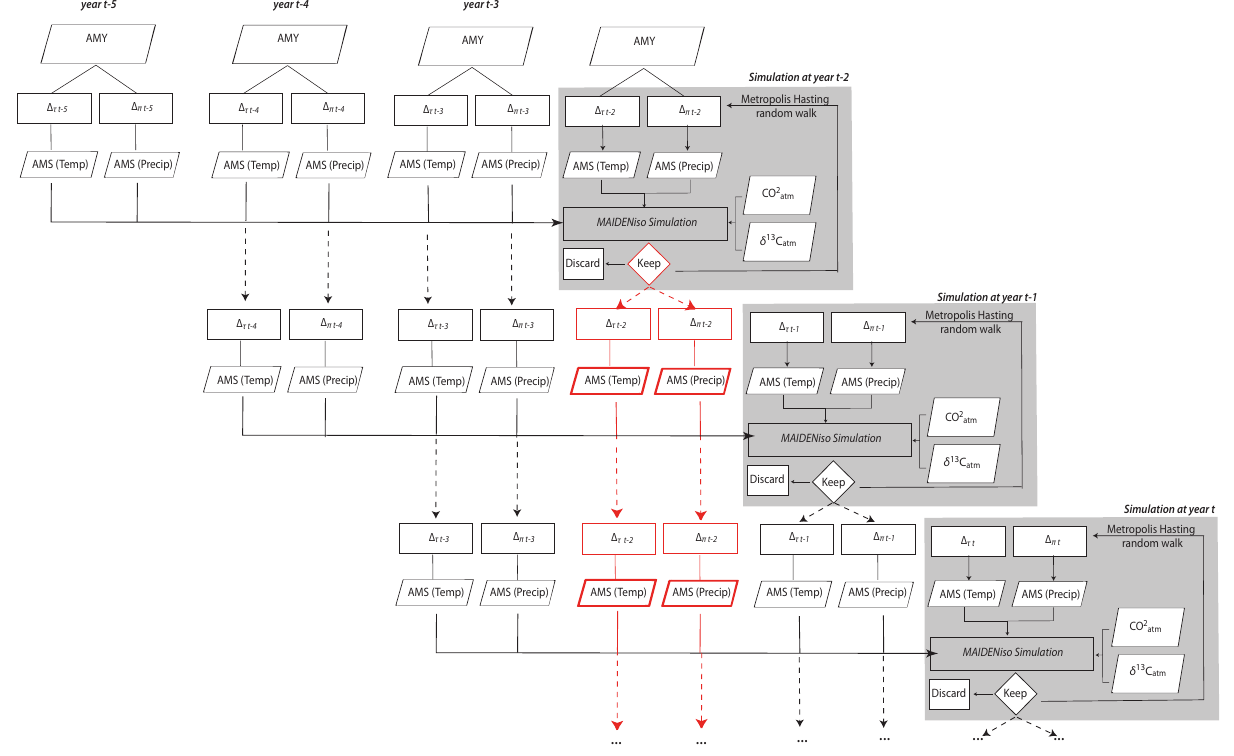
Figure 3. Flowchart of the autocorrelation modeling. Each gray box corresponds to the inversion algorithm presented in Fig. 1. For each year t where the inversion is conducted, AMS from the three preceding years is also given as input to MAIDENiso, so the simulation is performed on a total of 4 years (bold arrows). Once the best combination of 1 is found by the Metropolis–Hastings algorithm, the mean δ values are passed to the next iteration. An example is given by red dashed lines. 1 s found for year t − 2 are also used to simulate t − 1 and t .